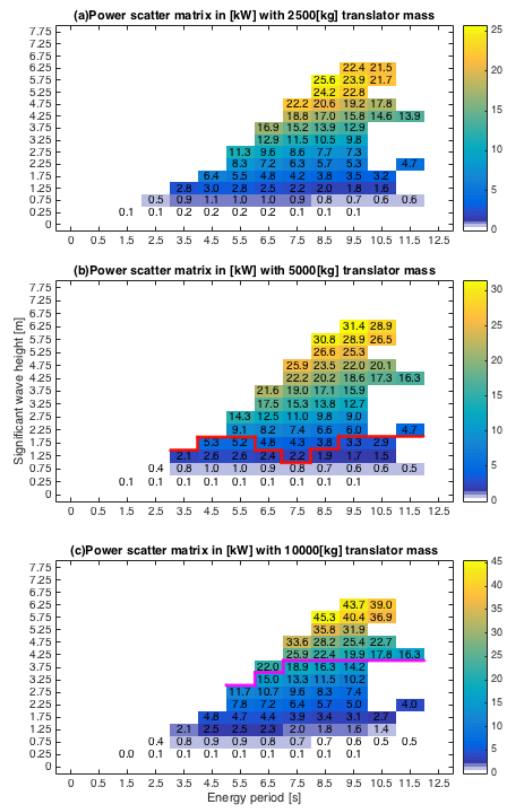
Figure 11. Average power (kW) matrix based on the wave climate at Site 6: ( a ) with a 2500 kg translator; ( b ) with a 5000 kg translator; ( c ) with a 10,000 kg translator. The red boundary line results from the comparison between ( a ) and ( b ); the violet boundary line results from the comparison between ( b ) and ( c ).